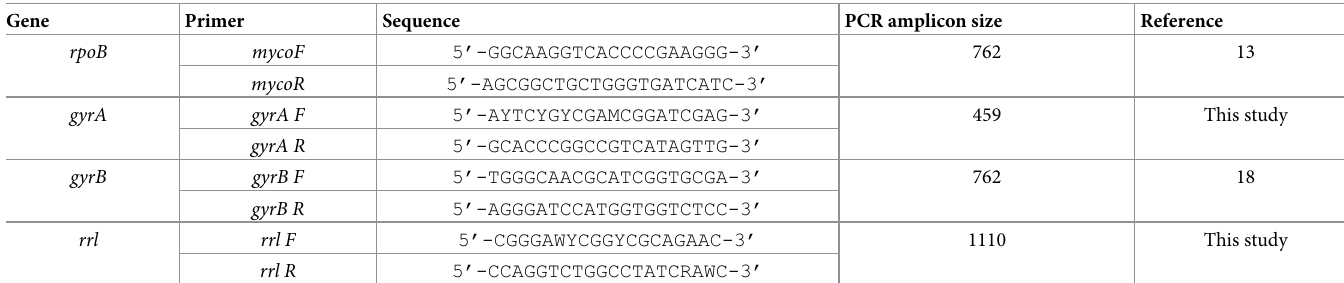
The minimum inhibitory concentration (MIC) of the antibiotics for the M . simiae isolates was determined by using the broth microdilution method and interpreted according to the Stan- dard Clinical and Laboratory Standards Institute (CLSI) recommendations [20]. Powdered forms of rifampin, isoniazid, ethambutol, linezolid, clofazimine, clarithromycin, moxifloxacin, and amikacin antibiotics were purchased from Sigma-Aldrich Company and were freshly pre- pared based on the manufacturer’s guidelines. To achieve the required dilution, a suitable amount of antibiotic stock was added to Middle Brook 7H9 broth (Fluka, Switzerland) con- taining 2 ml of glycerol and 100 mL of oleic acid/dextrose/catalase (OADC) growth supple- ment (Sigma-Aldrich). Growing colonies were gathered from the LJ medium and utilized to prepare a suspension with a concentration of 1.5 × 10 5 colony-forming units (CFU/ml) for wells inoculation. A volume of 100 μ l of 7H9 medium containing OADC was dispersed in 96-well microtiter plates. For each antibiotic, serial concentrations were established according to Table 3, and then 100 μ l of bacterial suspension was added to each well. Parafilm and zip lock bags were employed to keep the microplates from drying out during the 2-week incuba- tion period at 37˚C. The MIC is defined as a drug concentration that suppresses bacterial growth by approximately 100% macroscopically. Standard strains of Staphylococcus aureus ATCC 2921, Pseudomonas aeruginosa ATCC 27853, and Mycobacterium perginum ATCC 700686 have been used as quality control according to CLSI recommendations [20]. Table 2. Oligonucleotide primers used in PCR and sequencing.